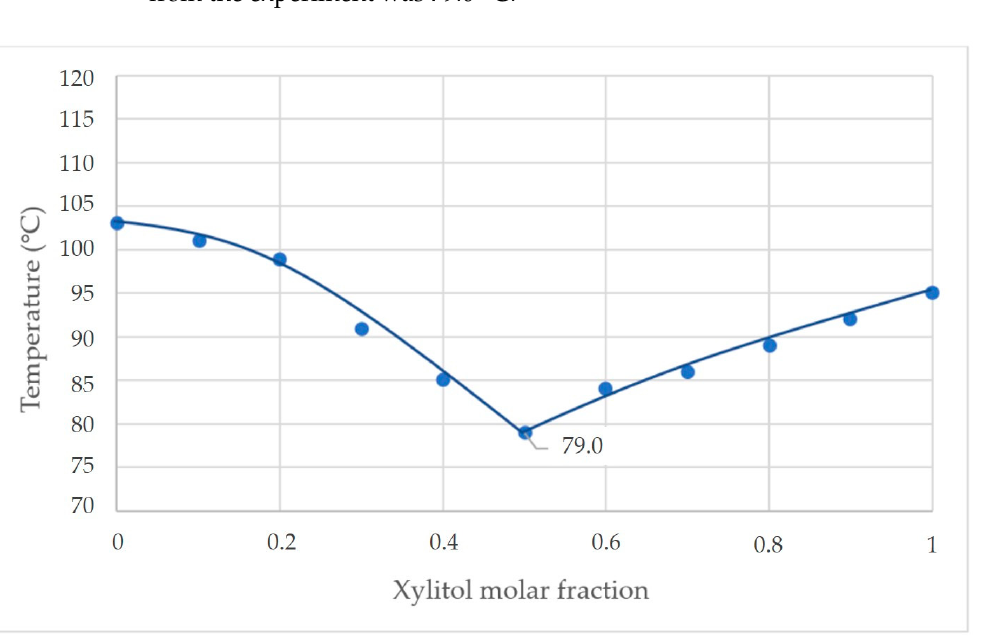
Figure 7. Phase diagram of the xylitol ‐ fructose system from experiment ( a ) and from calorimetry ( b ).